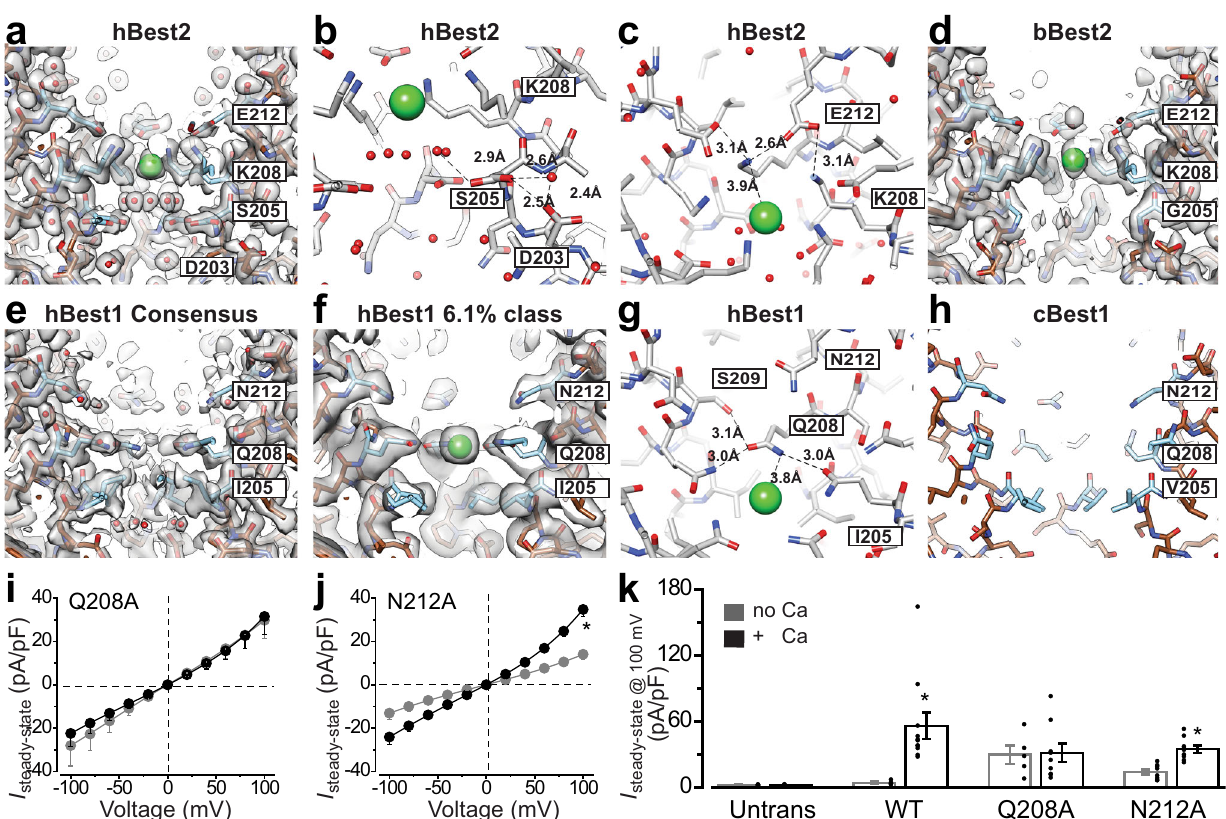
Fig. 6 The aperture in different bestrophin structures. Comparison of the aperture in Best2 a – d and Best1 e – h structures. The green dot represents a Cl − ion. a Side view of cryo-EM density map and model for hBest2. b hBest2 aperture viewed perpendicular to the central axis with dual conformations of S205. Bond distances between S205, D203, and water molecules are shown. c hBest2 bond distances between E212, K208, and a putative Cl − ion. d Cryo-EM density map and model for bBest2 side view. e , f Side view of cryo-EM density map and model for hBest1 consensus structure e , and a rare class with a putative Cl − ion bound at Q208 f . g Bond distances are shown for Q208, S209, and a putative Cl − ion in the same view as c . h Side view of cBest1 X-ray structure (4RDQ). i , j Population steady-state current density-voltage relationships in the absence (gray) and presence (black) of 1 μ M Ca 2 + from HEK293 cells expressing hBest1 Q208A i and N212A j ; n = 5 – 9 biologically independent cells for each point. * P < 0.05 compared to currents without Ca 2 + , using two-tailed unpaired Student t test. k Bar chart showing the steady-state current densities from HEK293 cells expressing the indicated channels in the absence and presence of 1 μ M Ca 2 + , n = 5 – 11 biologically independent cells for each bar. * P < 0.05 compared to currents without Ca 2 + , using two-tailed unpaired Student t test. Data are presen t ed as mean values ± SEM. Source data and the precise n and P values are provided in the Source Data fi